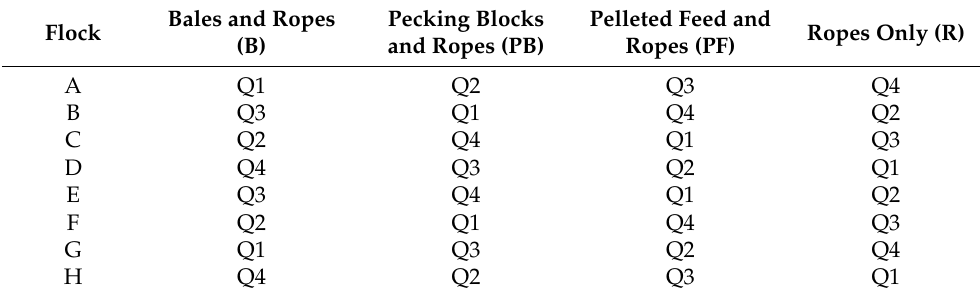
Table 1. Enrichment treatments (B, PB, PF, R), and their layout per flock, according to which quarter